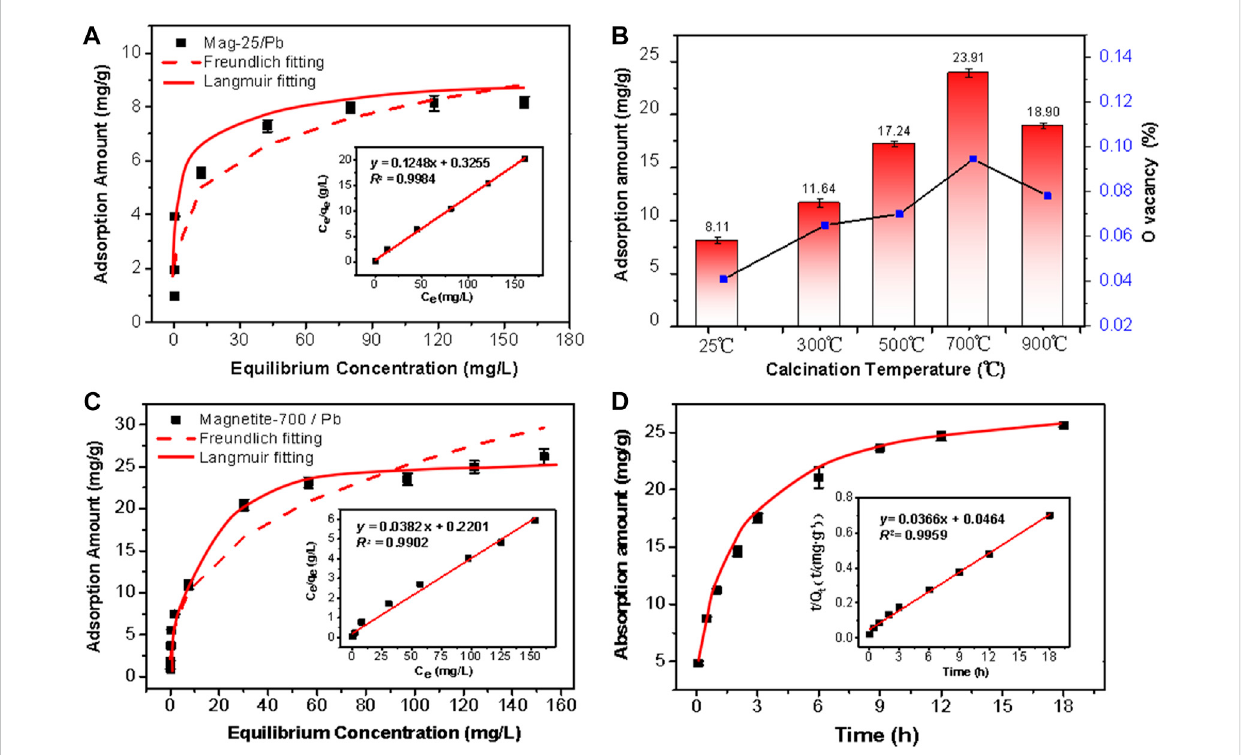
FIGURE 4 Pb(II)adsorptionby (A) Mag-25, (B) magnetiteatdifferentcalcinationtemperaturesandthecorrelationwithOxygenvacancy, (C) Mag-700.Thedata were fi tted to theLangmuir (solid line) and Freundlich (dashed line) isotherm models (A, C) . The insert isLangmuiradsorption isotherms model fi tting. (D) Kinetics of Pb(II) adsorption by Mag-700 fi tted to the pseudo-second-order kinetics (solid line). The insert is the linear plot of the pseudo-second-order